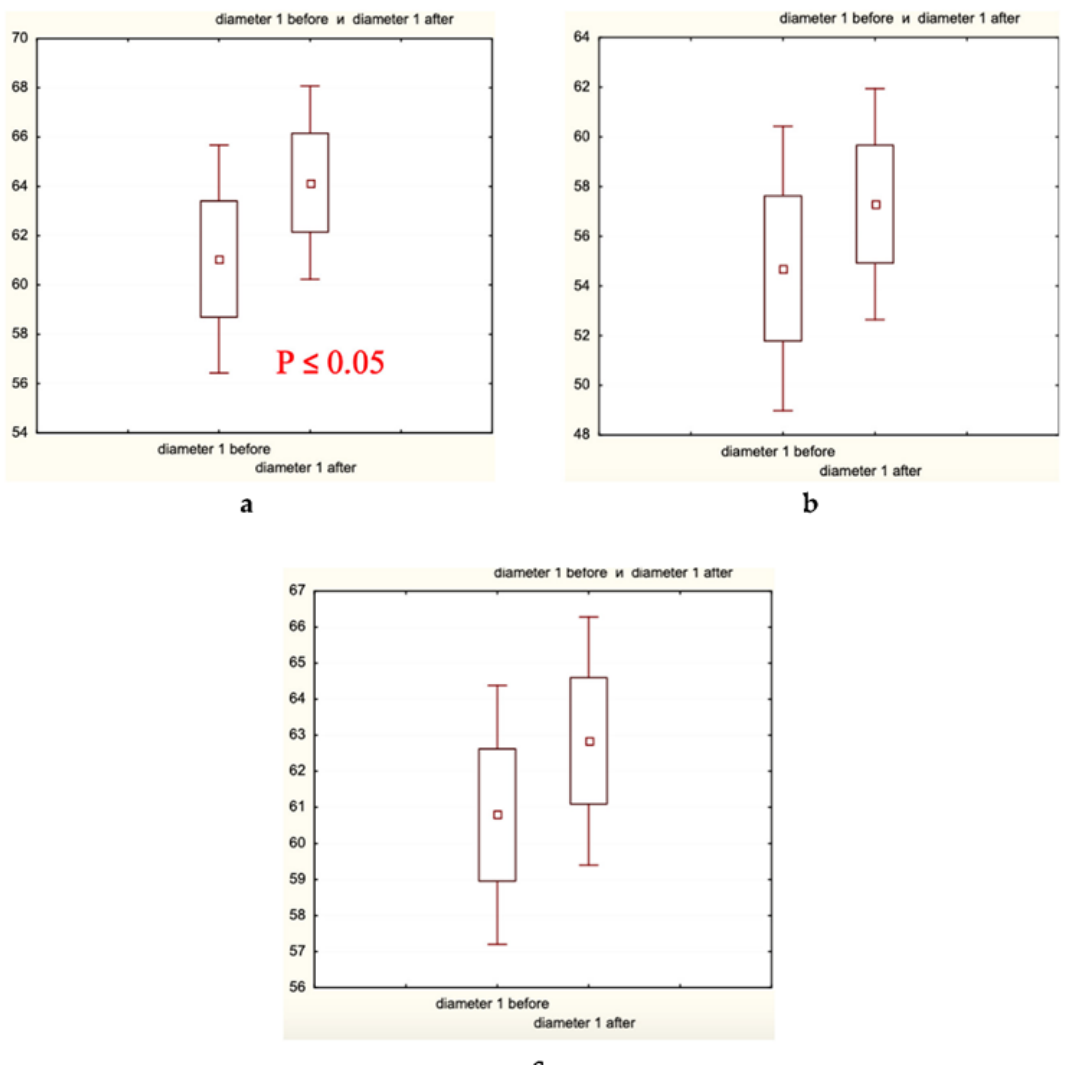
Figure 5. Hair diameter ( µ m) distribution before and after the trial: ( a ) Experimental Group 1; ( b ) Placebo Control Group 2; ( c ) Caffeine Control Group 3. Small boxes—median values; large boxes—median values ± standard error of median (SEM); whiskers—median values ± 1.96 SEM. p < 0.05.